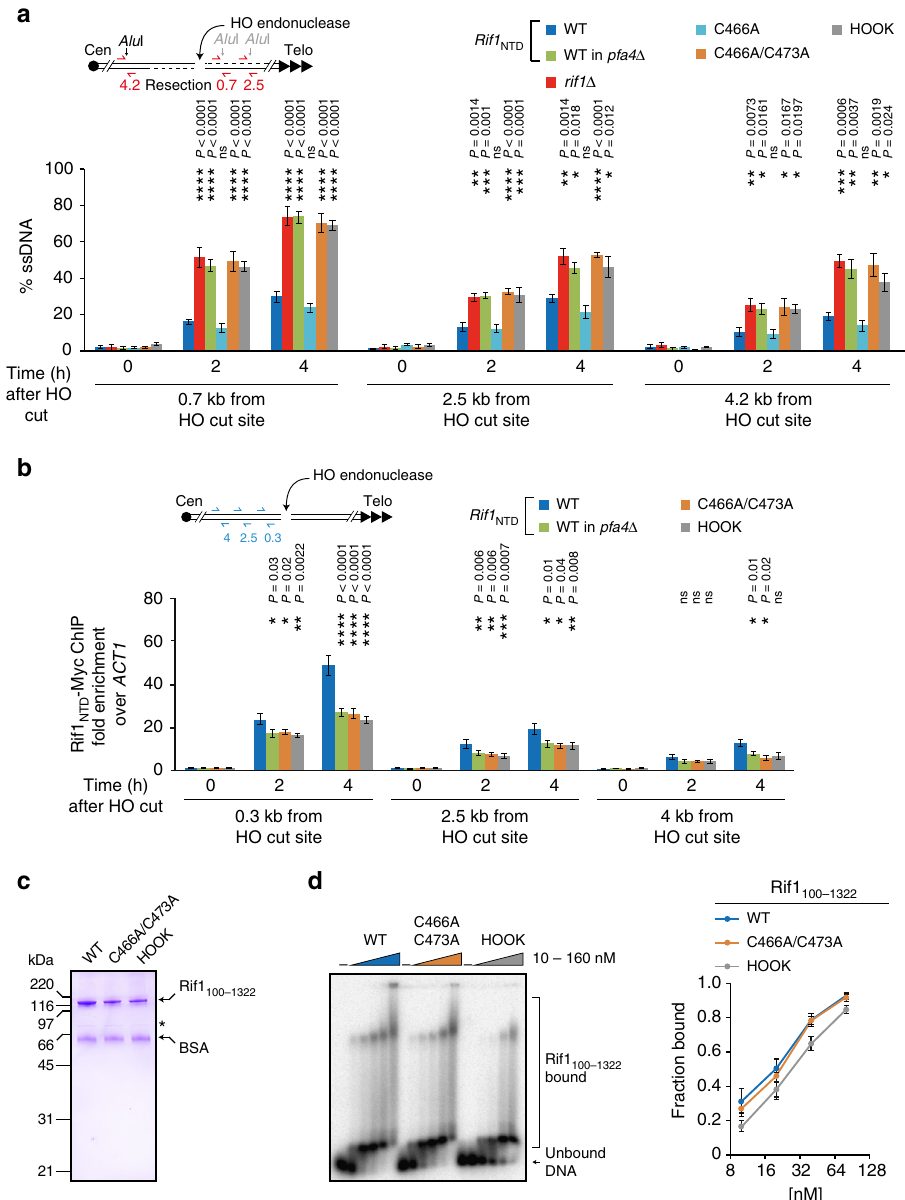
Fig. 3 Rif1 C466 and C473 are required for DSB end-protection and targeting. a DNA end-resection upon DSB induction at the MAT locus in strains expressing wild-type (WT) Rif1 NTD , the indicated Rif1 NTD mutants, or deleted for RIF1 . ssDNA formation was determined by qPCR as in Fig. 1d. Data are presented as mean values ± s.e.m. (n = 6 independent experiments). b Association of wild-type and mutant Rif1 NTD -Myc with the DSB at MAT . Results obtained with the indicated primers are reported as fold enrichment relative to ACT1 ± s.e.m. ( n = 6 independent experiments). Statistical analyses shown in panels a and b were performed by one-way Anova, followed by a post-hoc Tukey – Kramer multiple comparison test, comparing wild-type to the indicated mutants. c SDS-PAGE gel of puri fi ed Rif1 (residues 100 – 1322) variants used for DNA-binding assays, stained with Coomassie blue. Asterisk denotes an unspeci fi c band, BSA added for enhanced Rif1 stability. d EMSA analysis assessing the DNA-binding activity of the indicated Rif1 100 – 1322 variants (10 – 160 nM) using a 32 P-labeled 30 bp dsDNA (1 nM). Left, representative EMSA with free and Rif1-bound DNA species indicated. Right, quantitation of bound DNA presented as mean values ± s.e.m. ( n = 3 independent experiments). X-axis, log2 scale. See also Supplementary Fig. 3. Source data